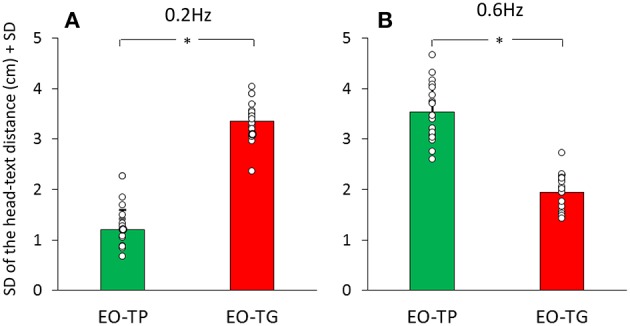
Mean standard deviation of the head-text distance at 0.2 Hz (A) and 0.6 Hz (B) translation frequency. Green bars correspond to the EO-TP condition, red bars to the EO-TG condition. The white dots superimposed to the bars correspond to the standard deviation of the head-text distance of all subjects. *Indicates a significant difference.